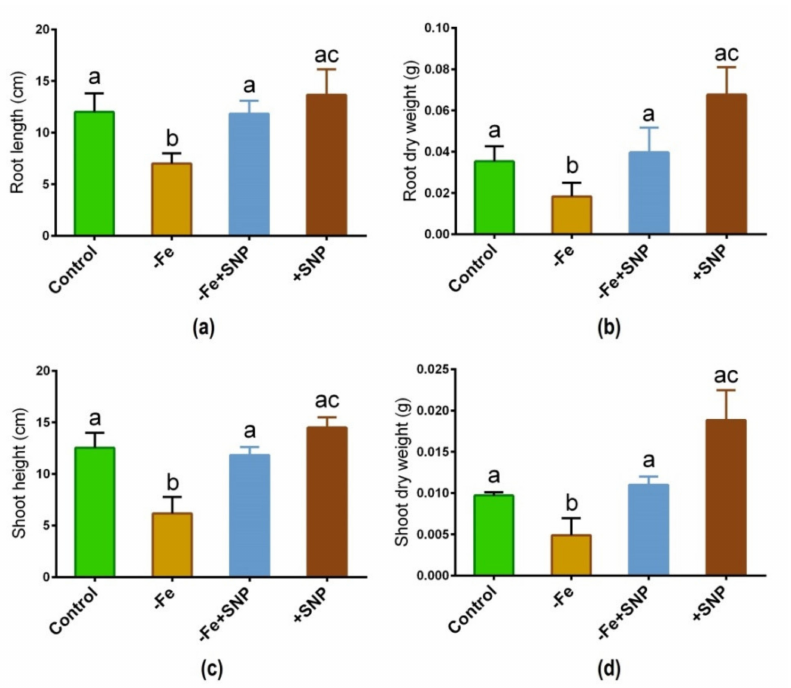
Figure 2. Root length ( a ), root dry weight ( b ), shoot height ( c ), and shoot dry weight ( d ) in alfalfa cultivated with different growth conditions: control (25 µ M FeNaEDTA); − Fe (0.1 µ M FeNaEDTA); − Fe (0.1 µ M FeNaEDTA) and sodium nitroprusside (SNP, 100 µ M) as nitric oxide (NO) donor; and SNP (100 µ M). Different letters above the error bar indicate significant differences ( p < 0.05) among means ± SD of treatments ( n =